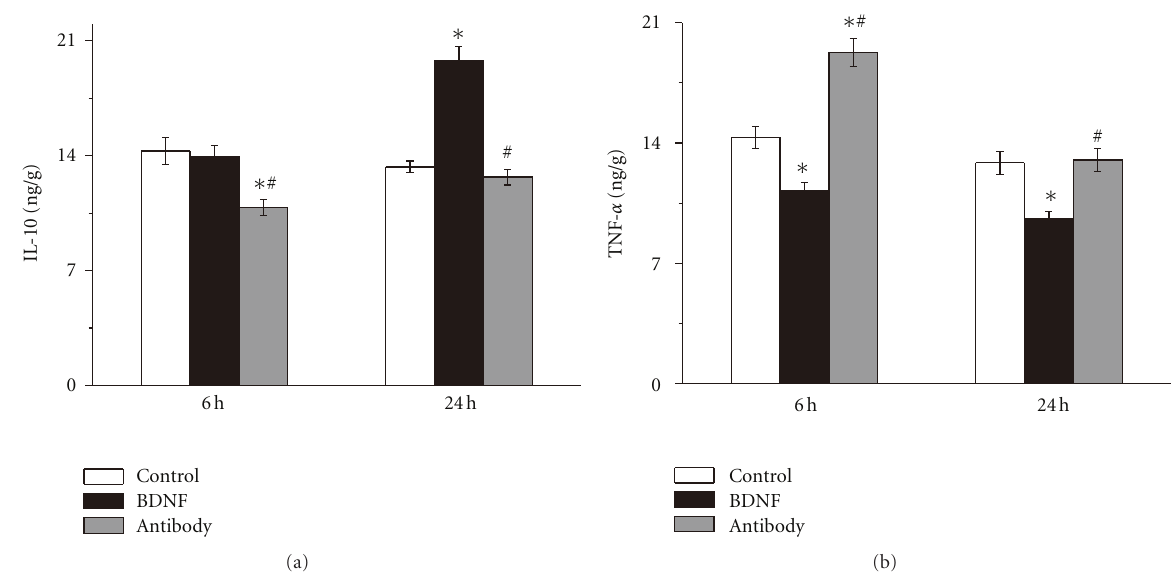
Figure 5: BDNF modulating local cytokine in brain after stroke Interleukin10 (IL10) and tumor necrosis factor α (TNF- α ) in rat brain after stroke were measured using ELISA kits. (a) Exogenous BDNF upregulated IL-10 24h after reperfusion while BDNF antibody decreased IL-10 6h after reperfusion. (b) Exogenous BDNF decreased TNF- α at 6 h and 24h of reperfusion than control group and BDNF antibody overwhelmed the e ff ect. Bars represent mean ± SD ( n = 6). ∗ P < . 05 versus control group, # P < . 05 versus BDNF group.